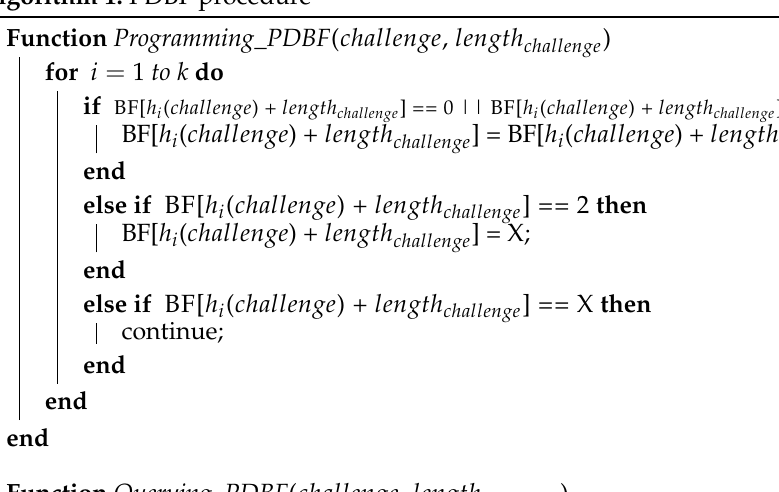
Algorithm 1: PDBF